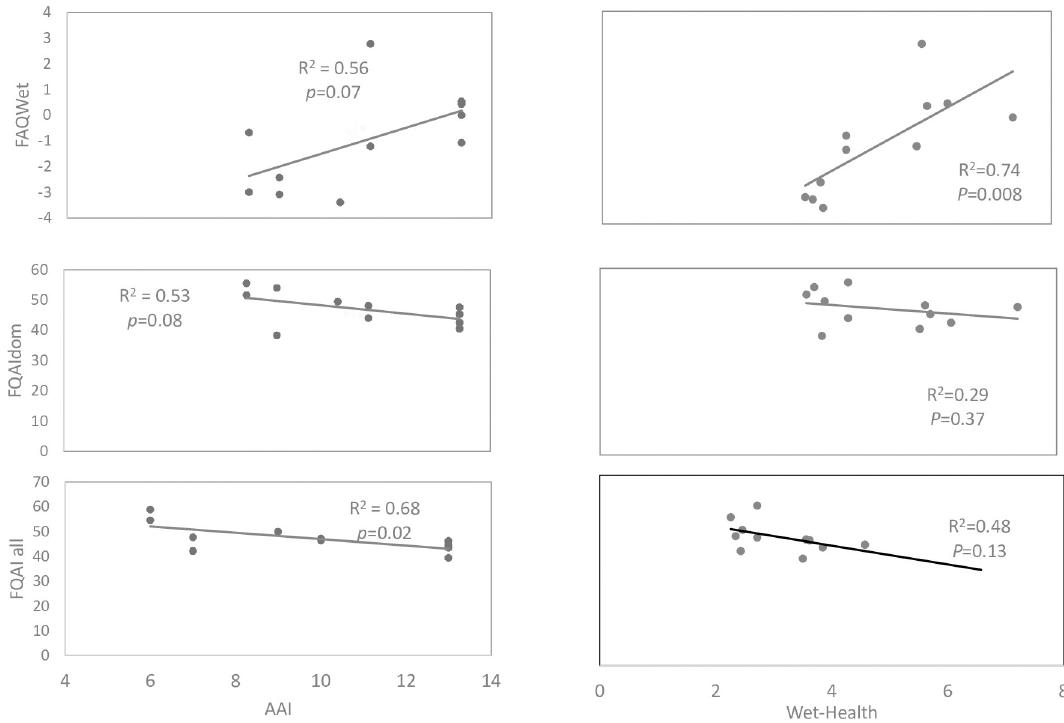
Fig 5. Comparison of linear regression analyses for FQAIall, FQAIdom, and FAQWet with AAI and WET-Health, for winter season for the 11 surveyed wetland sites.